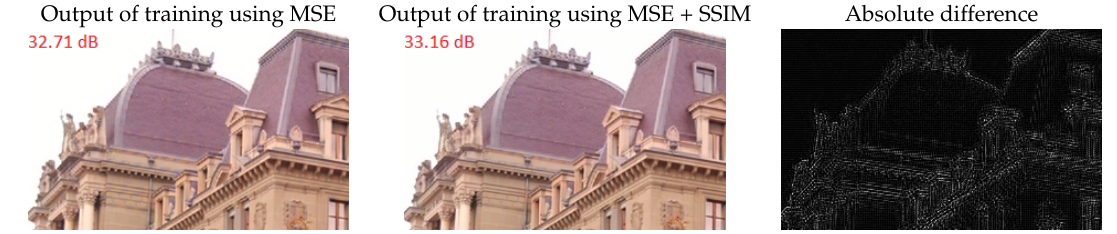
Figure 10. Effects of training with different loss functions ( left : mean squared error (MSE), middle : combination of MSE and structural similarity (SSIM) loss), mostly prominent around object edges ( right